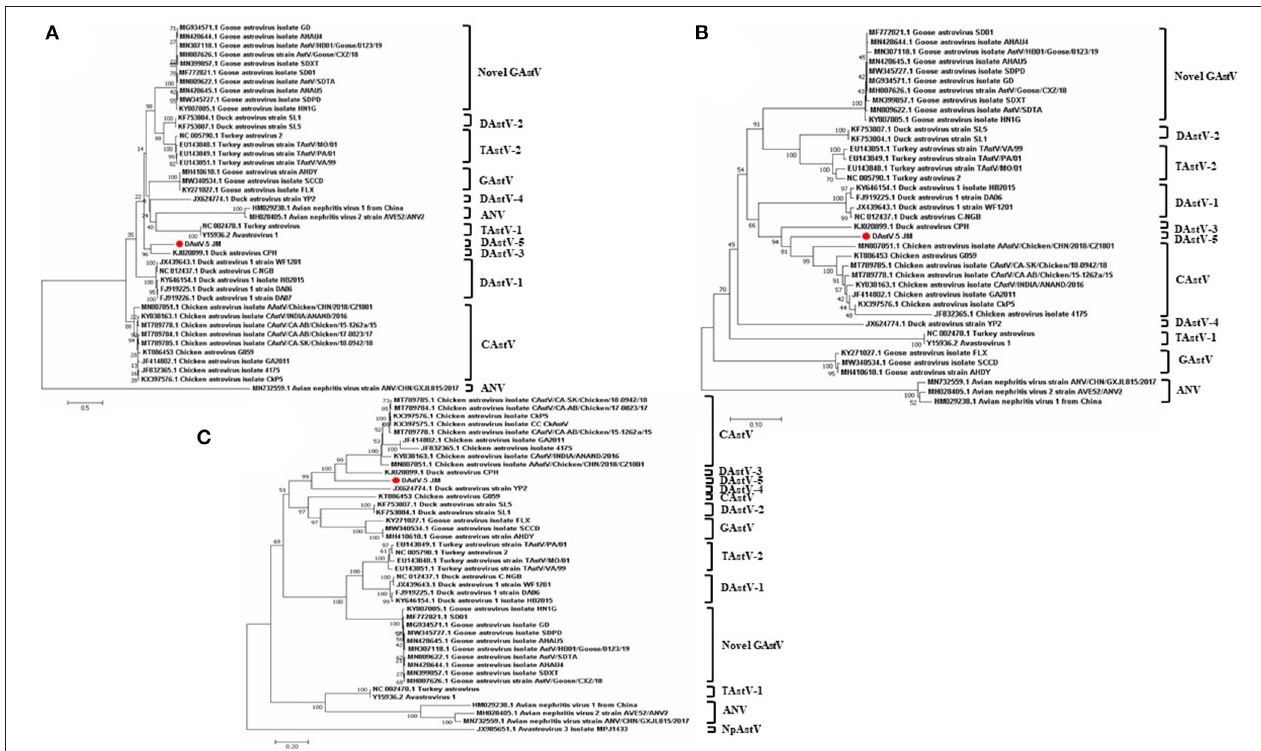
FIGURE 3 | Phylogenetic analysis of the amino acid sequences of ORF1a (A) , ORF1b (B) , and ORF2 (C) of the DAstV-5 JM strain and other astroviruses. The phylogenetic trees were constructed using MEGA 7.0 software using the neighbor-joining method, with 1,000 bootstrap replications. DAstV-5 JM strain, Duck